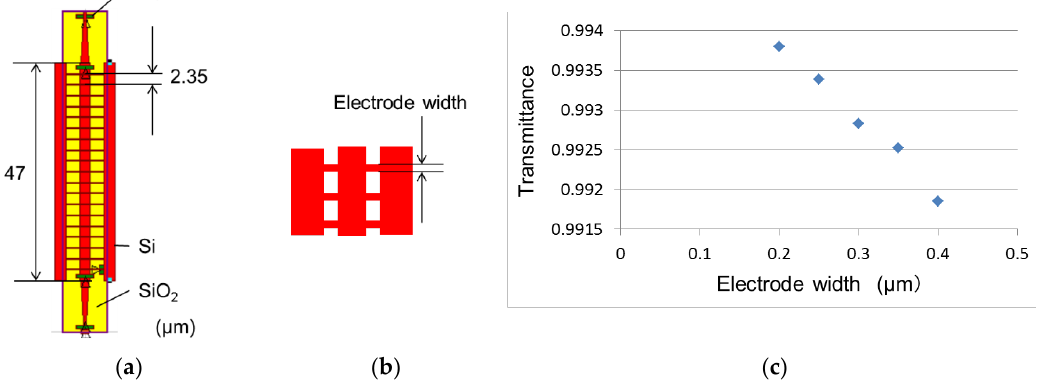
Figure 2. ( a ) Numerical calculation model of MMI phase modulator, ( b ) magnified drawing of electrode fin, and ( c ) transmittance (based on calculation results).